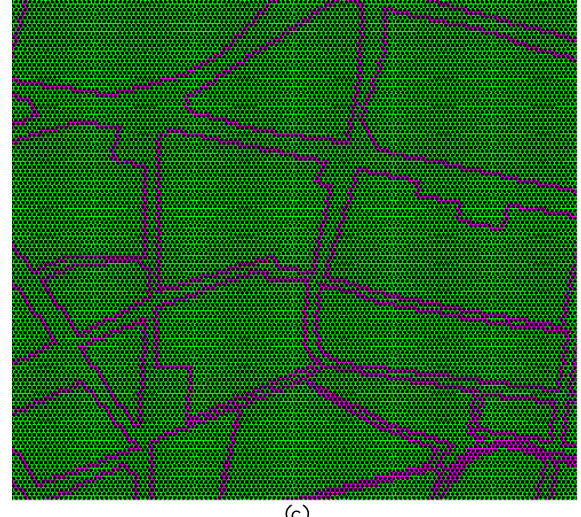
Figure 9. Display effects of different types of vector data in the hexagonal